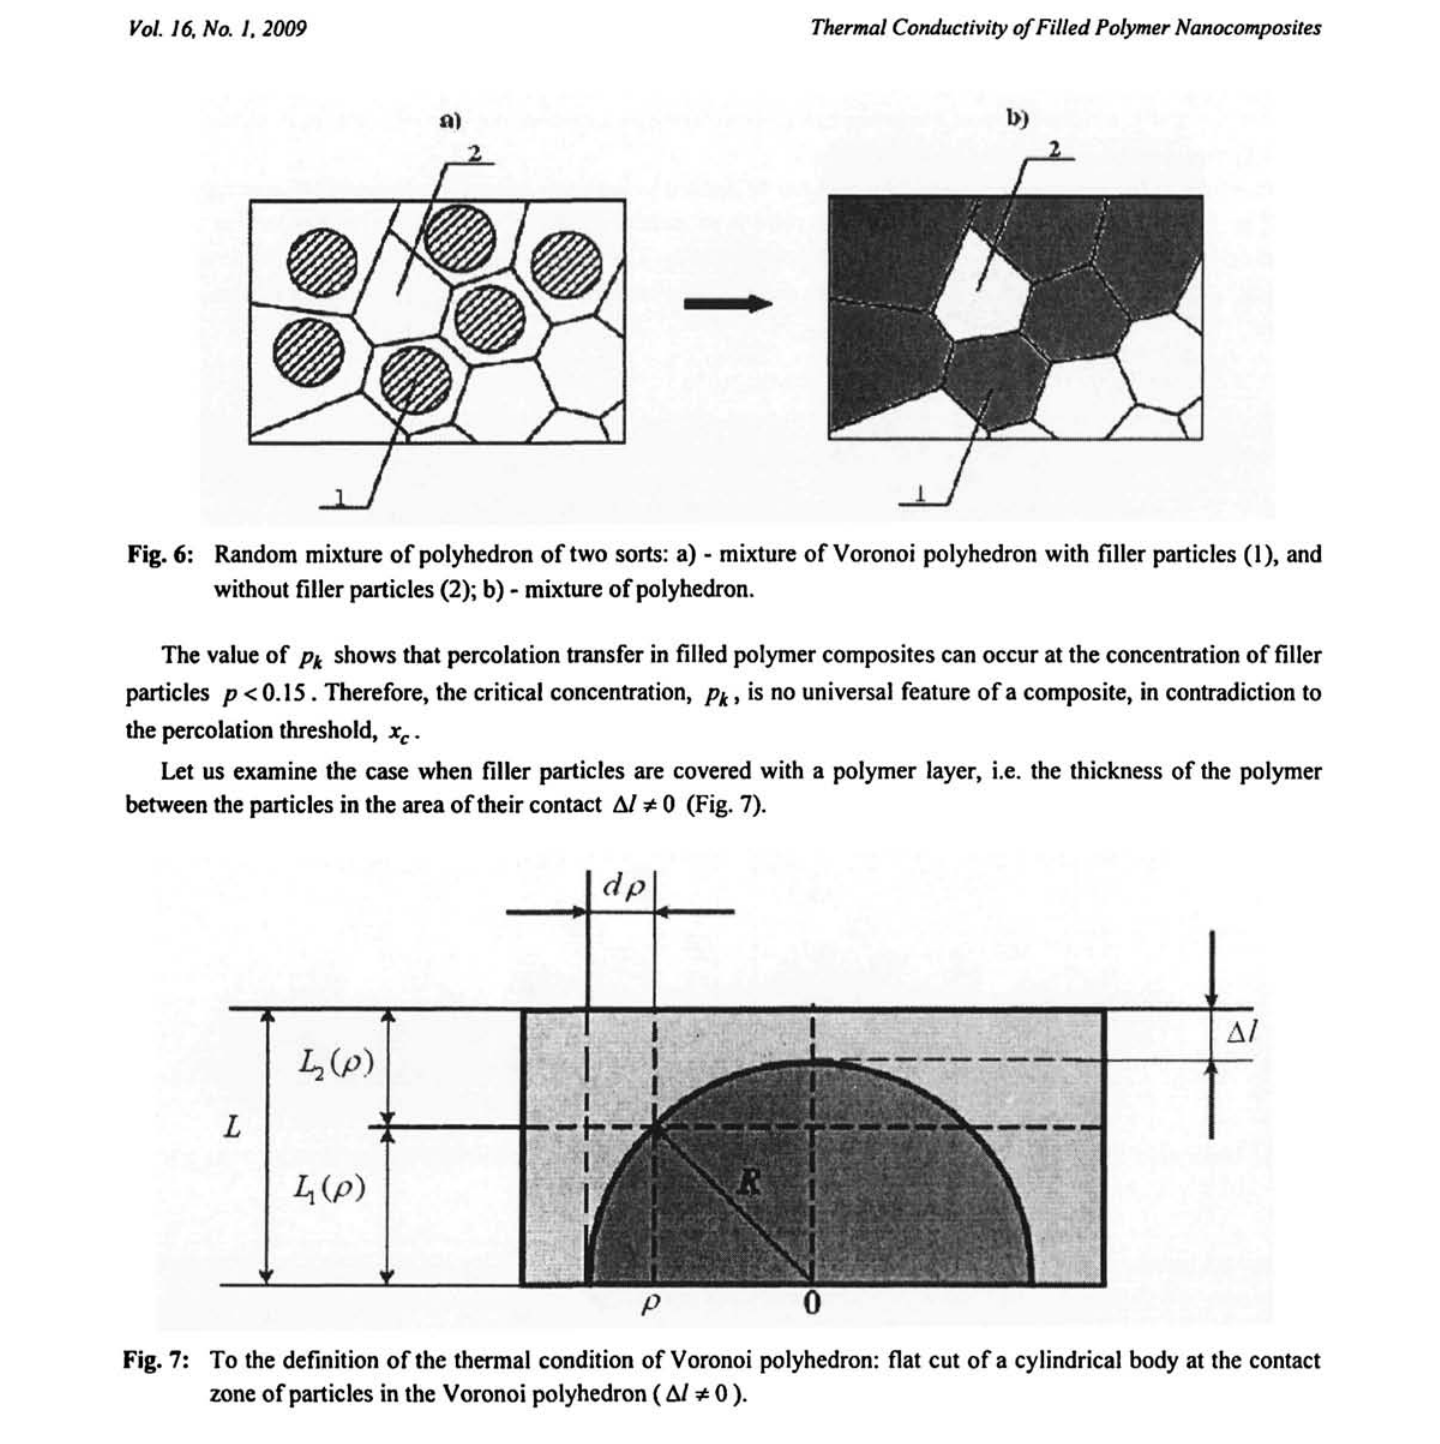
Fig. 7: To the definition of the thermal condition of Voronoi polyhedron: flat cut of a cylindrical body at the contact zone of particles in the Voronoi polyhedron (Δ/ * 0